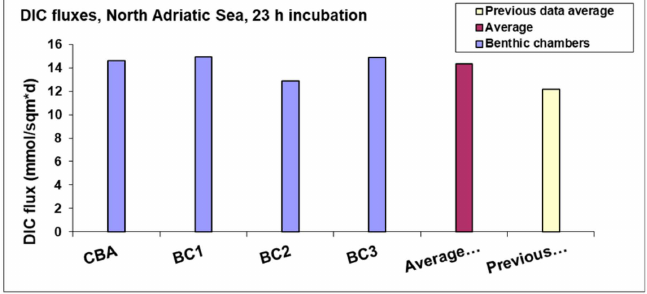
Figure 17. DIC fluxes measured by the CBA, by the Amerigo Lander (BC1, BC2, BC3), and in previous investigations at the same site, a mud bottom sediment rich in fresh organic matter (Po River